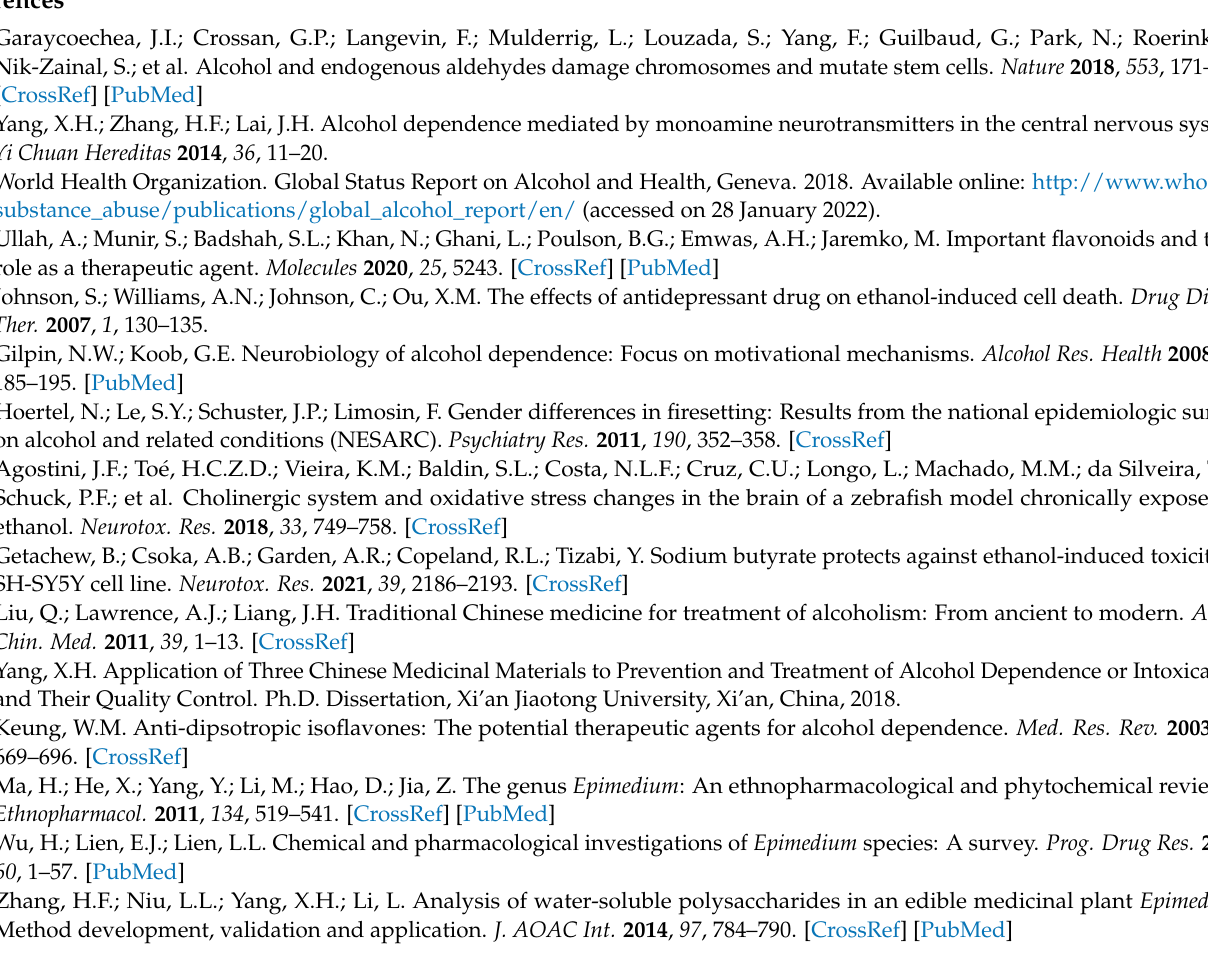
Supplementary Materials: Figure S1: HPLC profile of Epimedium flavonoids; Figure S2: Chemical structures of epimedin A, epimedin B, epimedin C, epimedin F and